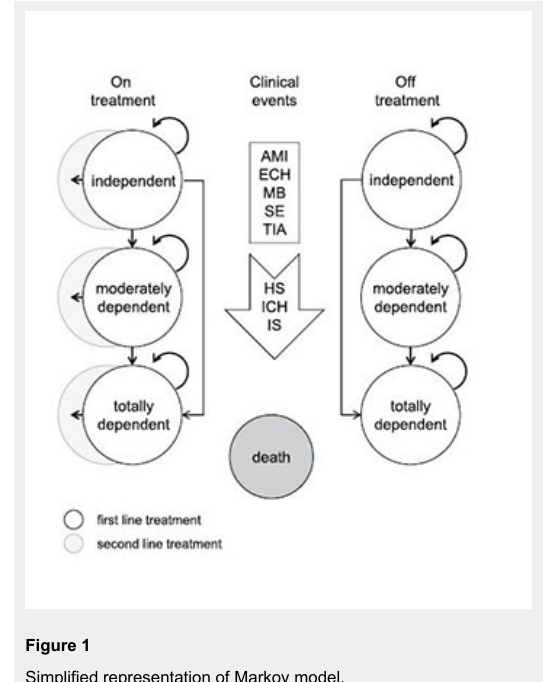
Simplified representation of Markov model. Health states are modelled in 3-month cycles in which a patient may experience no event, a clinical event, or death. All clinical events induce one-time treatment costs and a temporary loss